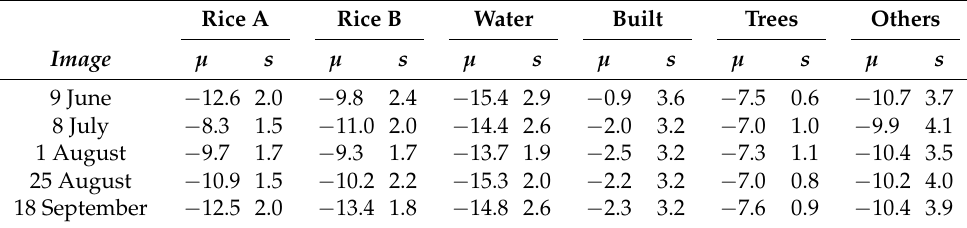
Table 3. Temporal backscatter coefficients for all land-cover classes at VV polarization.